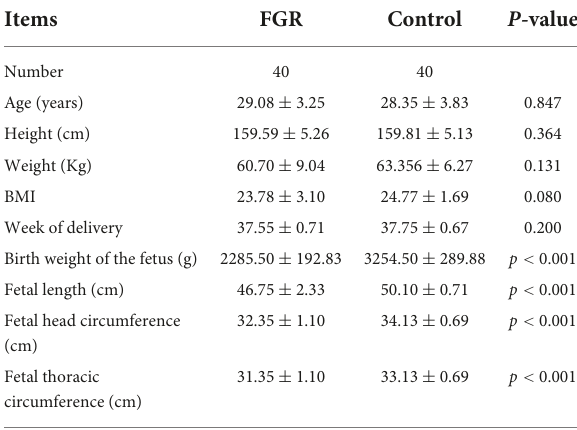
TABLE 2 Summary of clinical